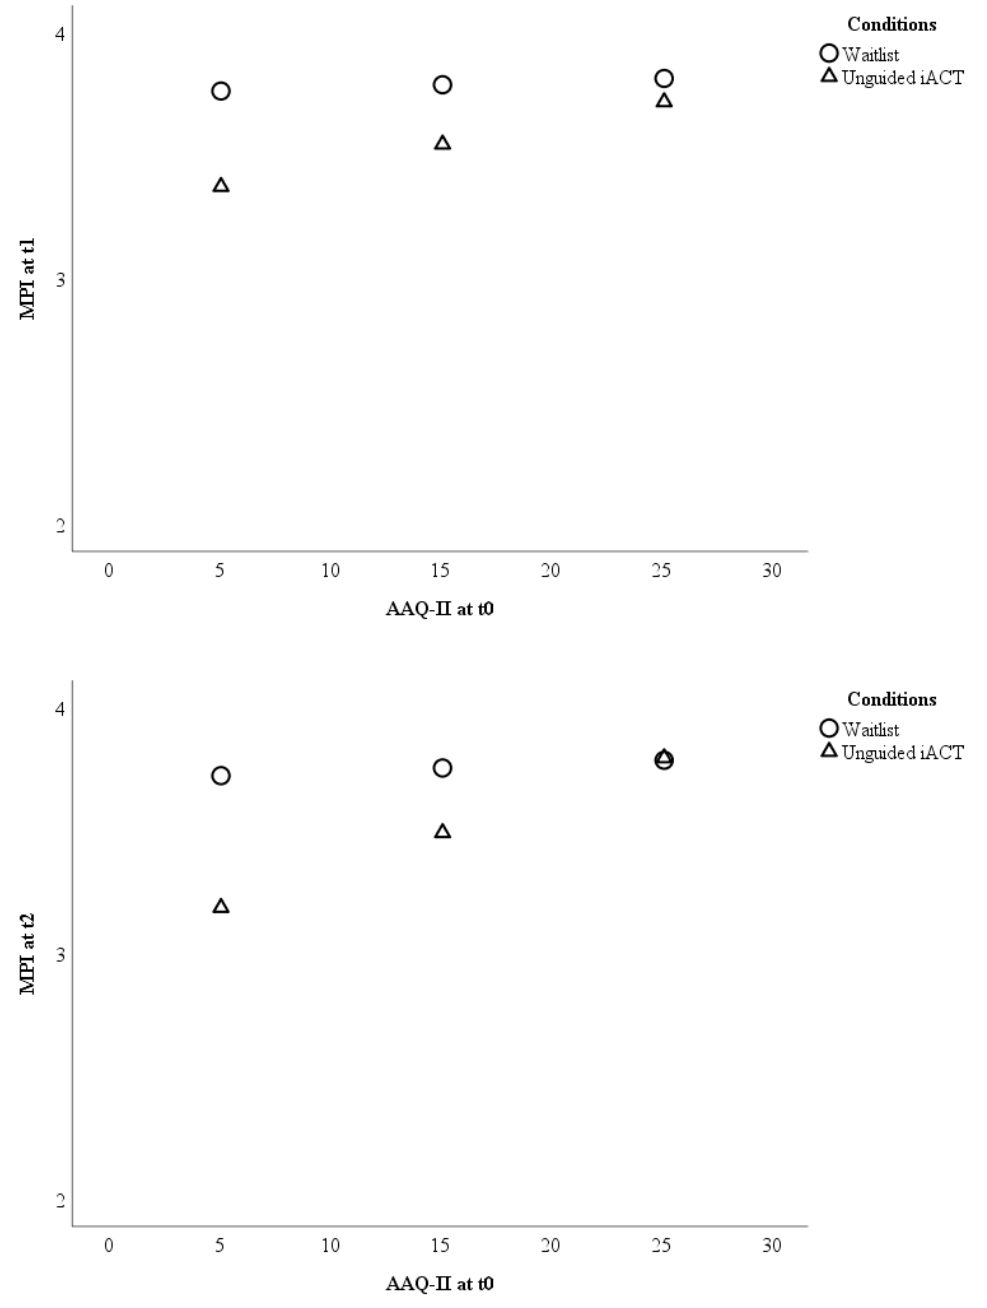
Figure 2. Visualizations of the results testing baseline psychological inflexibility as a moderator of the treatment outcome pain interference between waitlist and unguided Internet-based ACT. The outcome ( Y -axis) is displayed for three different levels (sample mean ± 1 standard deviation) of psychological inflexibility ( X -axis). Note: AAQ-II = Acceptance and Action Questionnaire; iACT = Internet-based Acceptance and Commitment Therapy; MPI = Pain interference scale of the Multidimensional Pain Inventory; t0 = baseline; t1 = 9-weeks after randomization; t2 = 6-months after